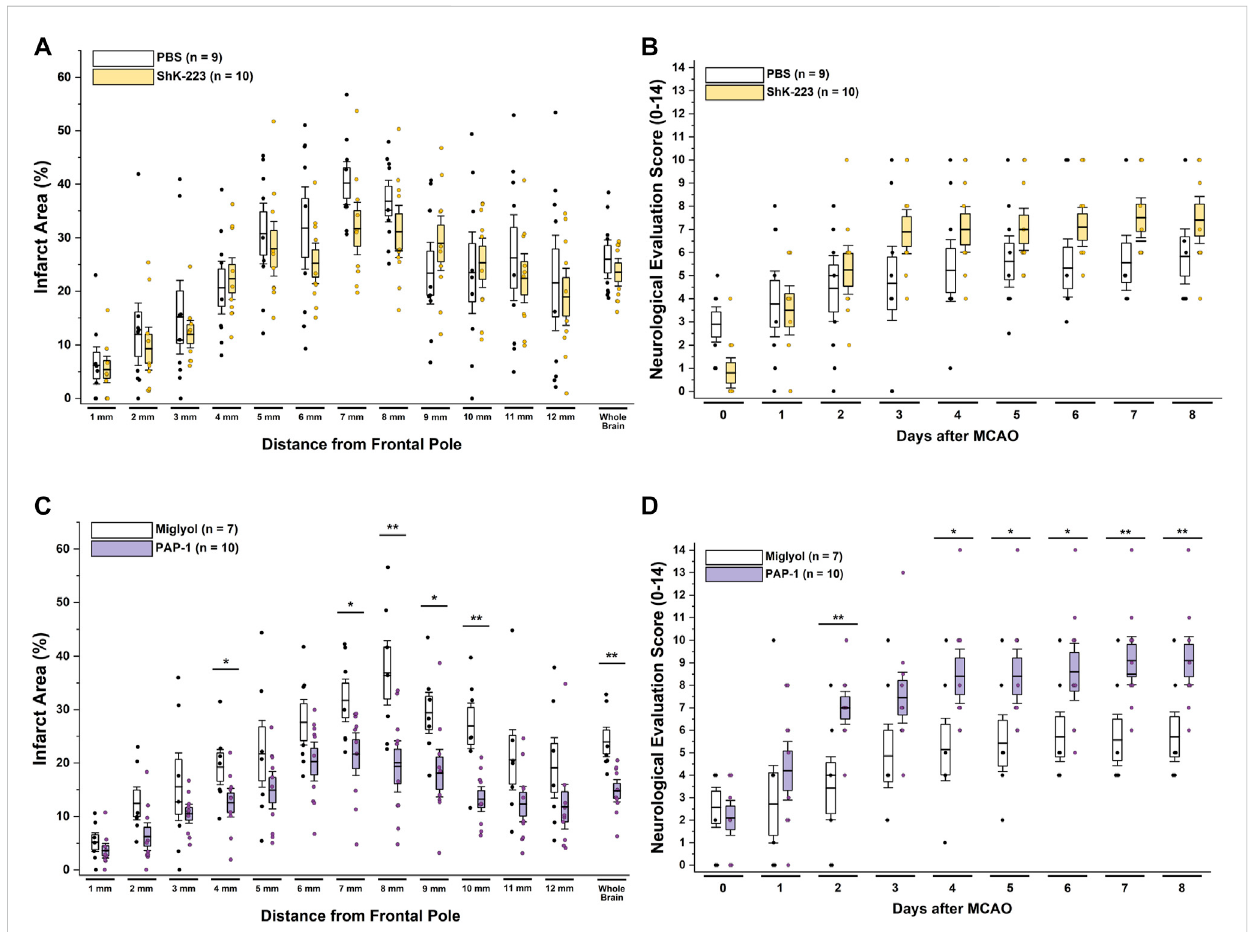
FIGURE 2 The K V 1.3 blocker PAP-1 but not the peptide ShK-223 reduces infarction and improves neurological de fi cit in adult male rats. (A) Infarct area and (B) neurological de fi cit score in PBS (n = 9) compared to ShK-223 (100 mg/kg; n = 10) treated male Wistar rat. (C) Infarct area and (D) neurological de fi cit scoreinmiglyolvehicle(n=7)comparedtoPAP-1(40 mg/kg;n=10)treatedmalerats( p =0.002forinfarct, p =0.009forNESonday-8).Dataareshown as whisker plots with data from individual animals overlayed as scatter. The boxes show mean ± S.E.M; the whiskers show con fi dence